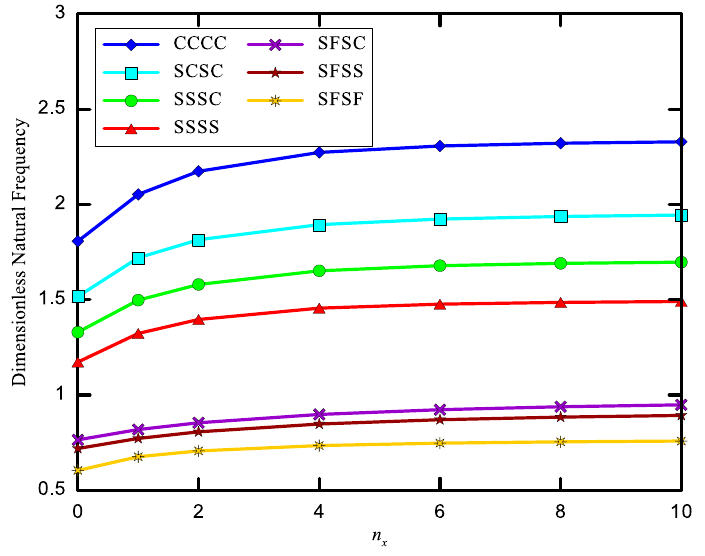
Fig. 6. Variation of non-dimensional natural frequency 𝝎̅ with nz for (1-8-1) sandwich plate with different boundary